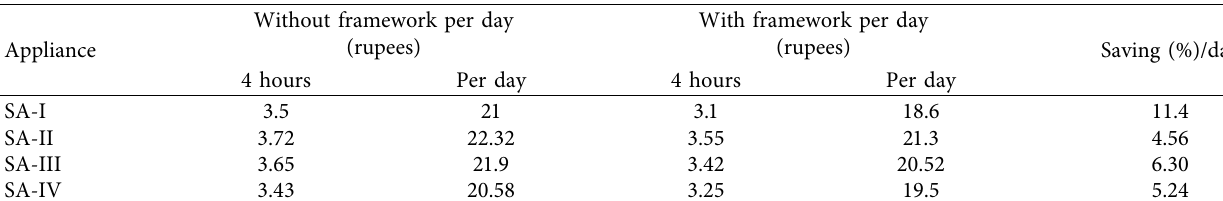
Figure 8: Comparative analysis. Table 3: Cost saving comparison.